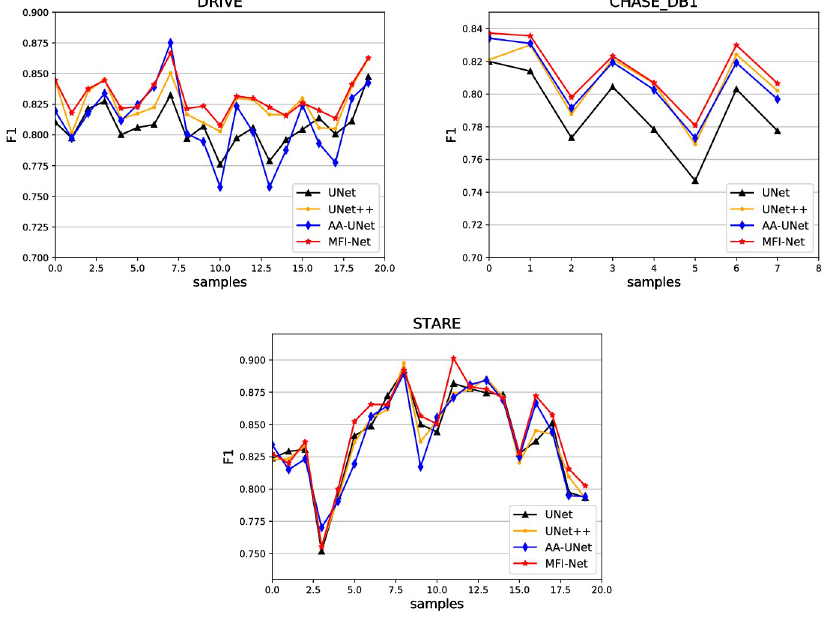
Fig 8. F1 performance curve on three datasets. The abscissa represents the sample picture number in the dataset, the ordinate represents the F1 for semantic segmentation of the image. https://doi.org/10.1371/journal.pone.0253056.g008 one dataset and then test it on another dataset. Table 7 shows the results of the cross-test, where the horizontal table header is the dataset used for training and the vertical table header indicates the dataset used for testing. To visualize the test results, we visualized the segmenta- tion results as shown in Fig 9. The F1 and accuracy of the models trained on the DRIVE dataset decreased by 5.52% and 0.4% when tested with the STARE dataset, and by 42.52% and 2.46% when tested with CHAS- E_DB1. The F1 and accuracy of the model trained on the STARE dataset decreased by 5.30% and 0.96% when tested with the DRIVE dataset, and by 24.11% and 2.13% when tested with CHASE_DB1. The F1 and accuracy of the models trained on the CHASE_DB1 dataset decreased by 15.33% and 2.33% when tested with the DRIVE dataset, and by 2.98% and 0.68% when tested with STARE.